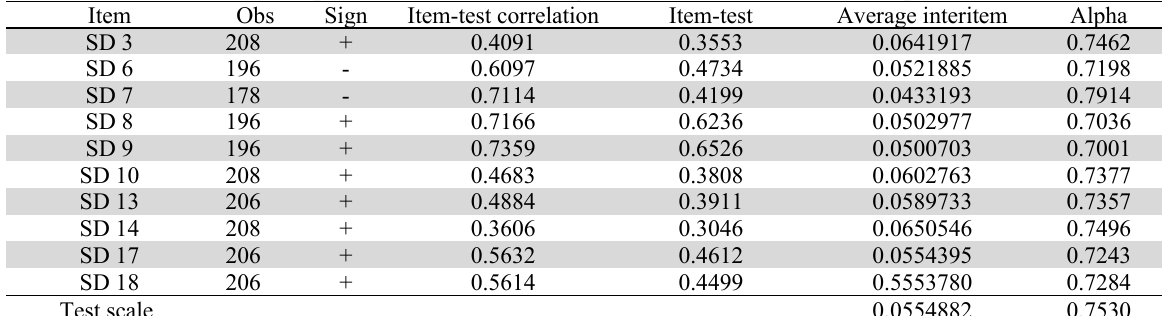
The results of Cronbach Alpha for factors affecting business sustainable development